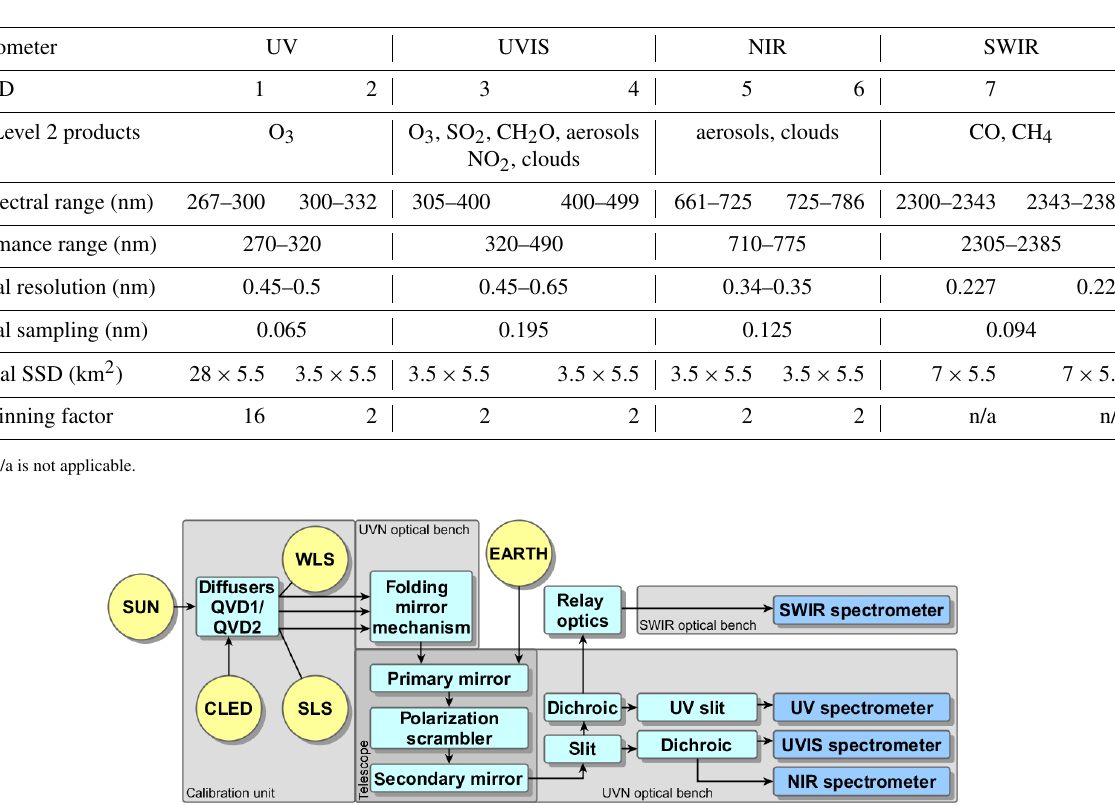
Table 1. Main products and characteristics of the four TROPOMI spectrometers and the definition of the spectral bands with identifiers 1–8. The listed values are based on on-ground calibration measurements (see Kleipool et al., 2018) and are valid at the detector centre. The performance range is the range over which the requirements are validated; the full range is larger. The nominal spatial sampling distance (SSD) is given at nadir for the updated operations scenario.